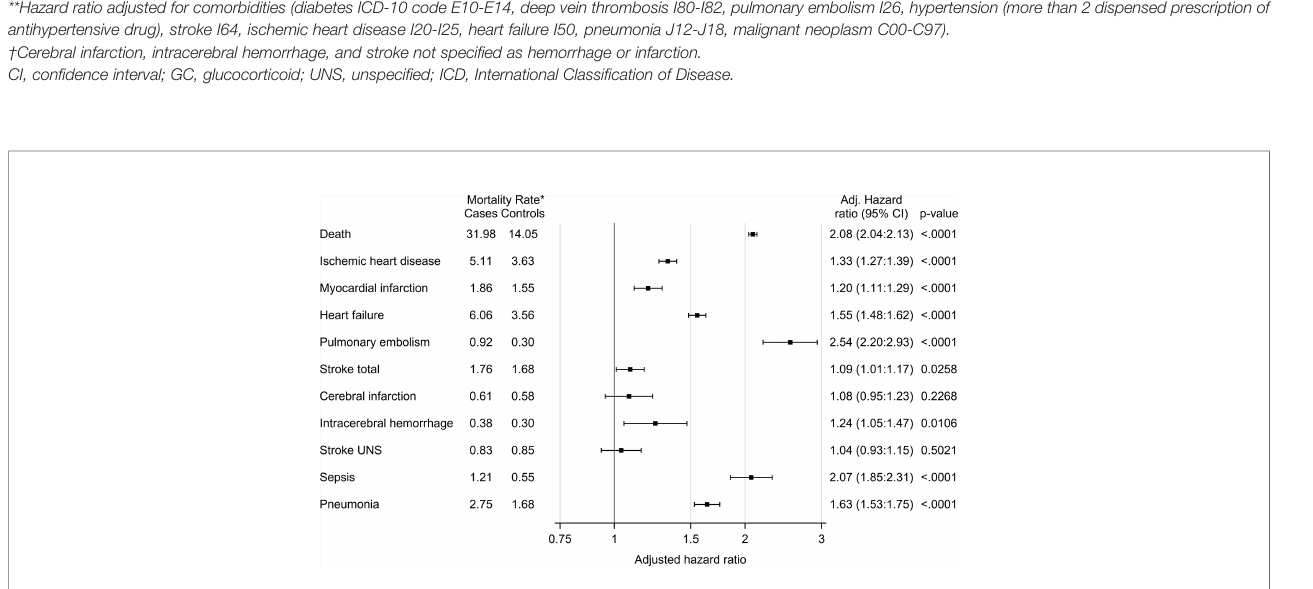
FIGURE 1 | All-cause mortality and disease-speci fi c mortality in glucocorticoid users (cases) compared to age- and sex-matched controls. The hazard ratio was calculated using Cox proportional hazard model. The hazard ratio was adjusted for age, sex and comorbidities (diabetes, deep vein thrombosis, pulmonary embolism, hypertension, stroke, ischemic heart disease, heart failure, pneumonia, malignant neoplasm). *Number of deaths per 1000 patient